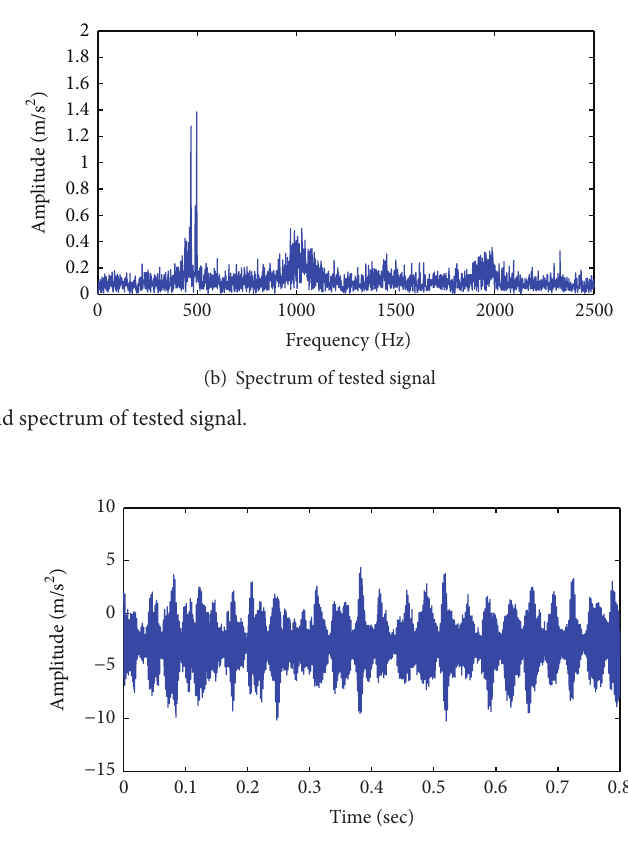
Figure 12: Envelope spectrum of tested signal.